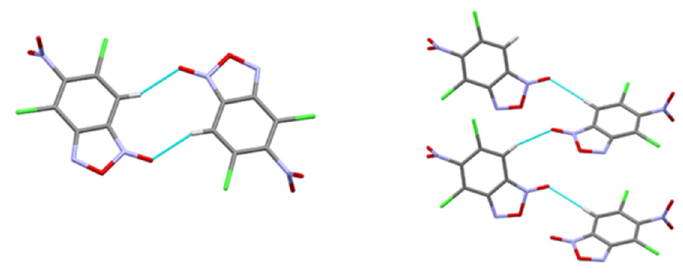
Figure 6. Packing of 1a ( left ) and 1b ( right ).